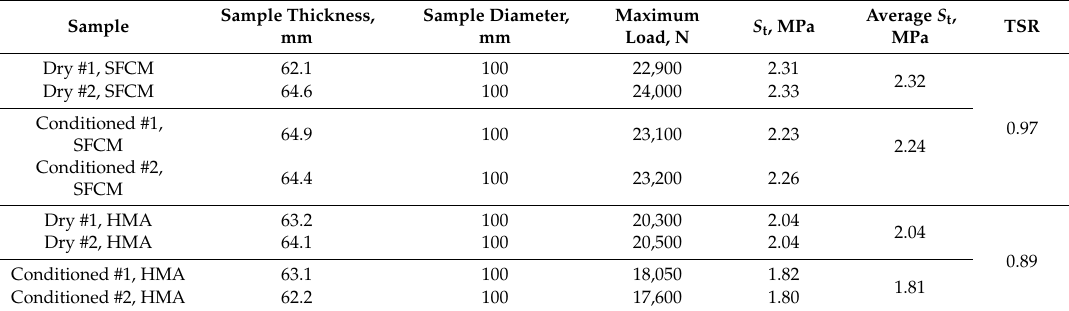
Table 1. Summary of indirect tensile (IDT) strength testing results (25 ◦